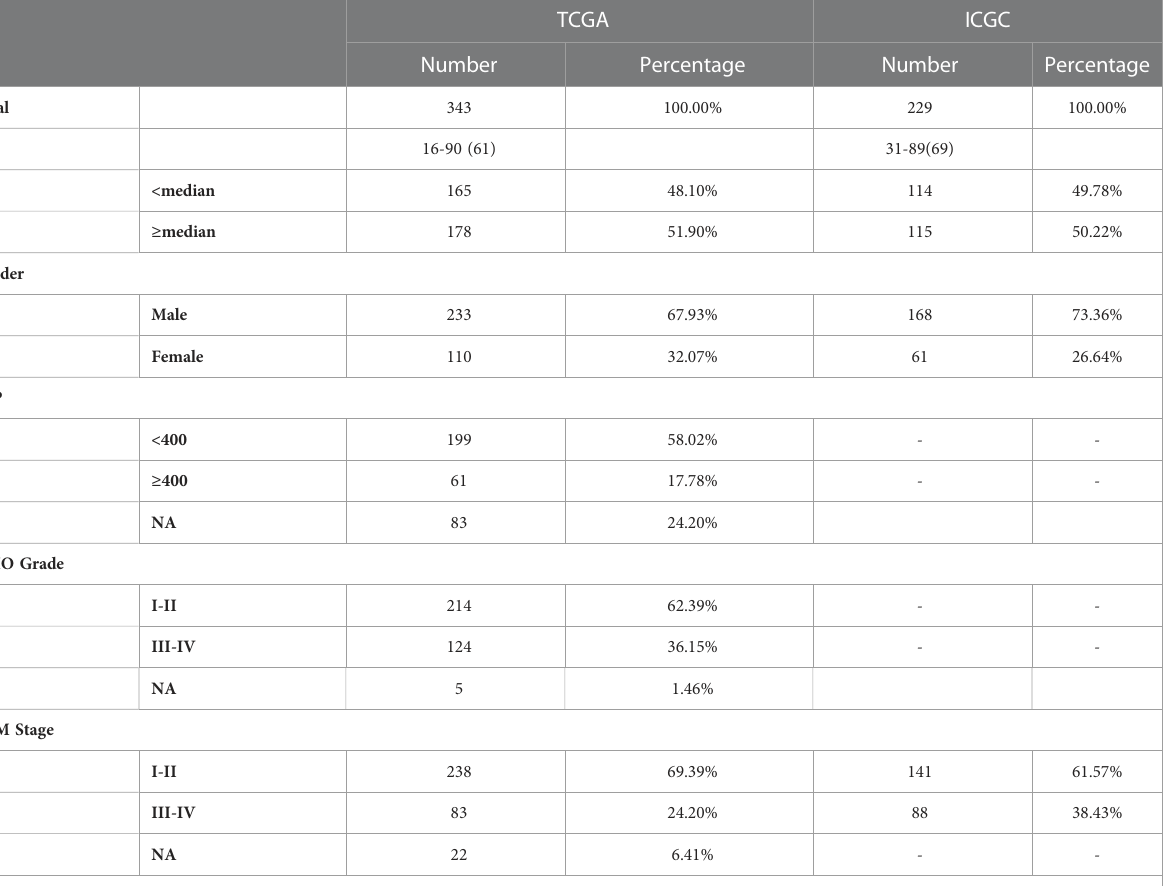
Figure 1. IBM SPSS Statistics 25 and R Programming Language (4.0.0) were used to statistical analysis in this study.